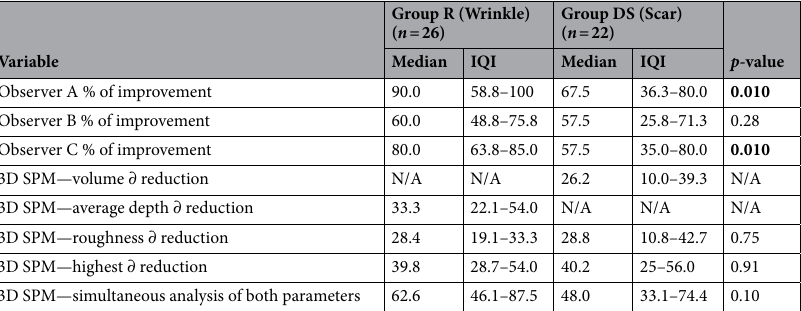
Table 2. Mann–Whitney test analysing the estimated percentage of skin improvement provided by the observers and 3D SPM objective data. Results by group. IQI interquartile interval (25th percentile–75th percentile), N/A non-applicable.